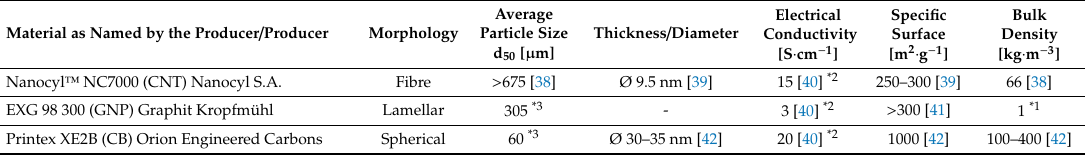
Table 1. Specifications of the used commercial carbon filler material